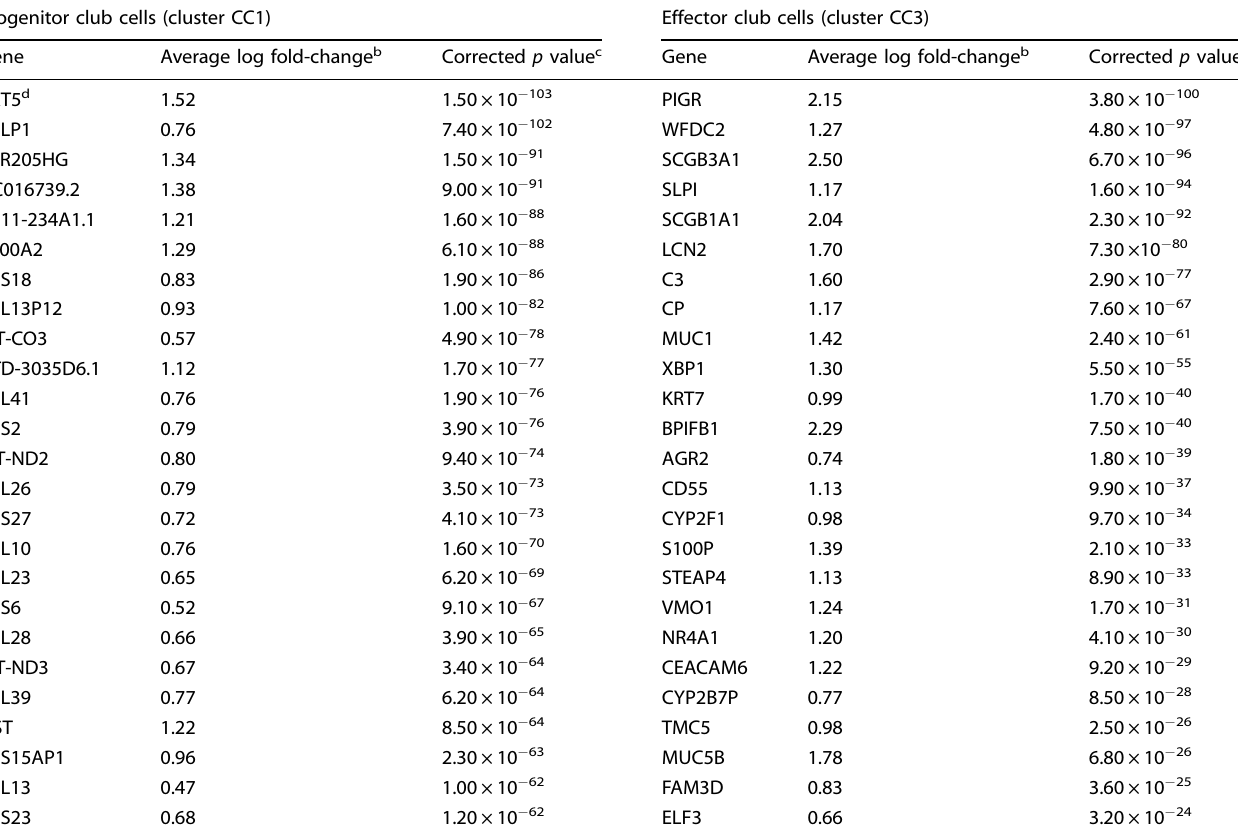
Table 2. Differentially expressed genes in progenitor vs. effector club cells a . Progenitor club cells (cluster